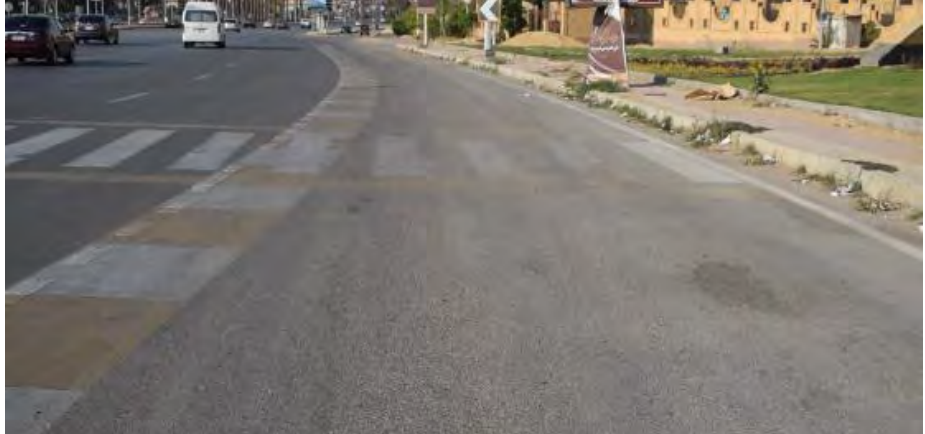
Fig. 27: Absence of special rain drainage. (Source: the